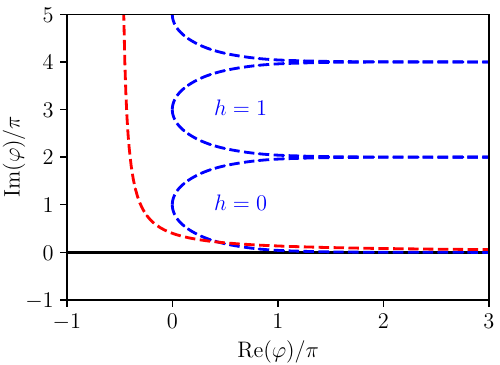
Figure 8 . The L-shape contour (red dashed curve) is a sum of elementary cycles (blue dashed curves) with h > 0 , and is obtained as a result of continuing the c ≥ 25 Liouville path integral on R (black solid curve) to the vicinity of c ≤ 1